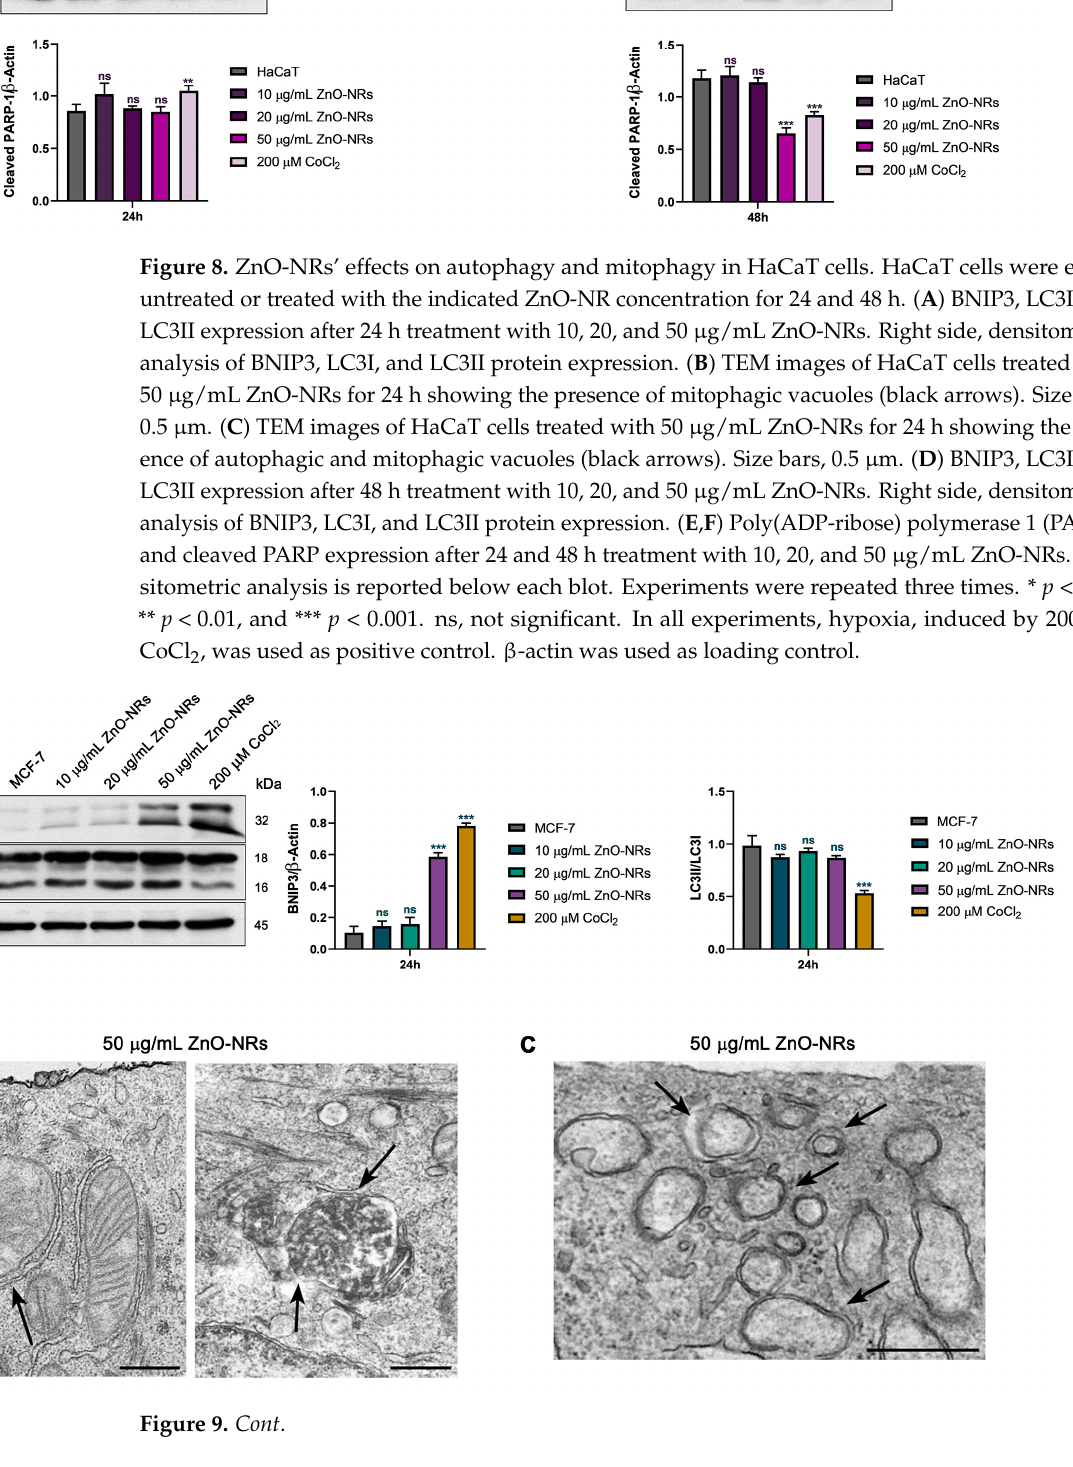
Figure 9. ZnO-NRs’ e ff ects on autophagy and mitophagy in MCF-7 cells . MCF-7 cells were either untreated or treated with the indicated ZnO-NR concentration for 24 and 48 h. ( A ) BNIP3, LC3I, and LC3II expression after 24 h treatment with 10, 20, and 50 µg/mL ZnO-NRs. Right side, densitometric analysis of BNIP3 and LC3II protein expression. ( B ) TEM images of MCF-7 cells treated with 50